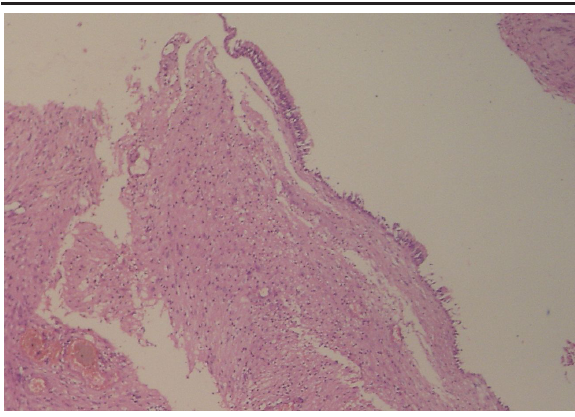
figure 2. nasal leiomyoma: Unencapsualted smooth muscle tumor under the nasal mucosa. (H&e, 5X10)